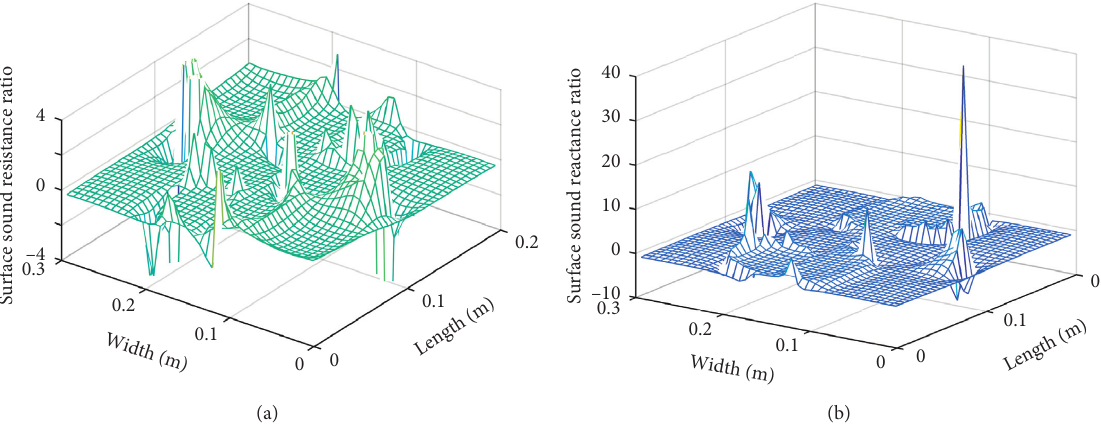
Figure 8: Surface sound impedance ratio of the active MPPA on the resonant frequency of the (2, 3) mode after control: (a) sound resistance ratio and (b) sound reactance